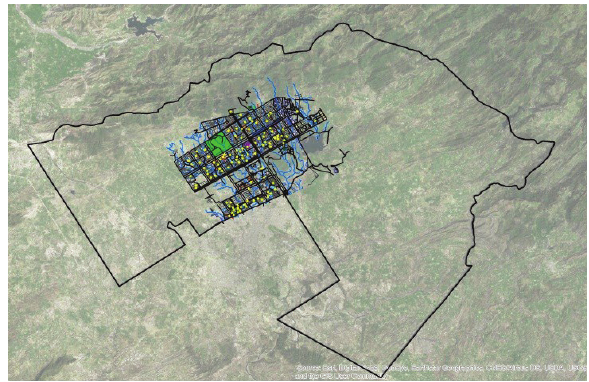
Figure 1. Map of Islamabad (source: ARC